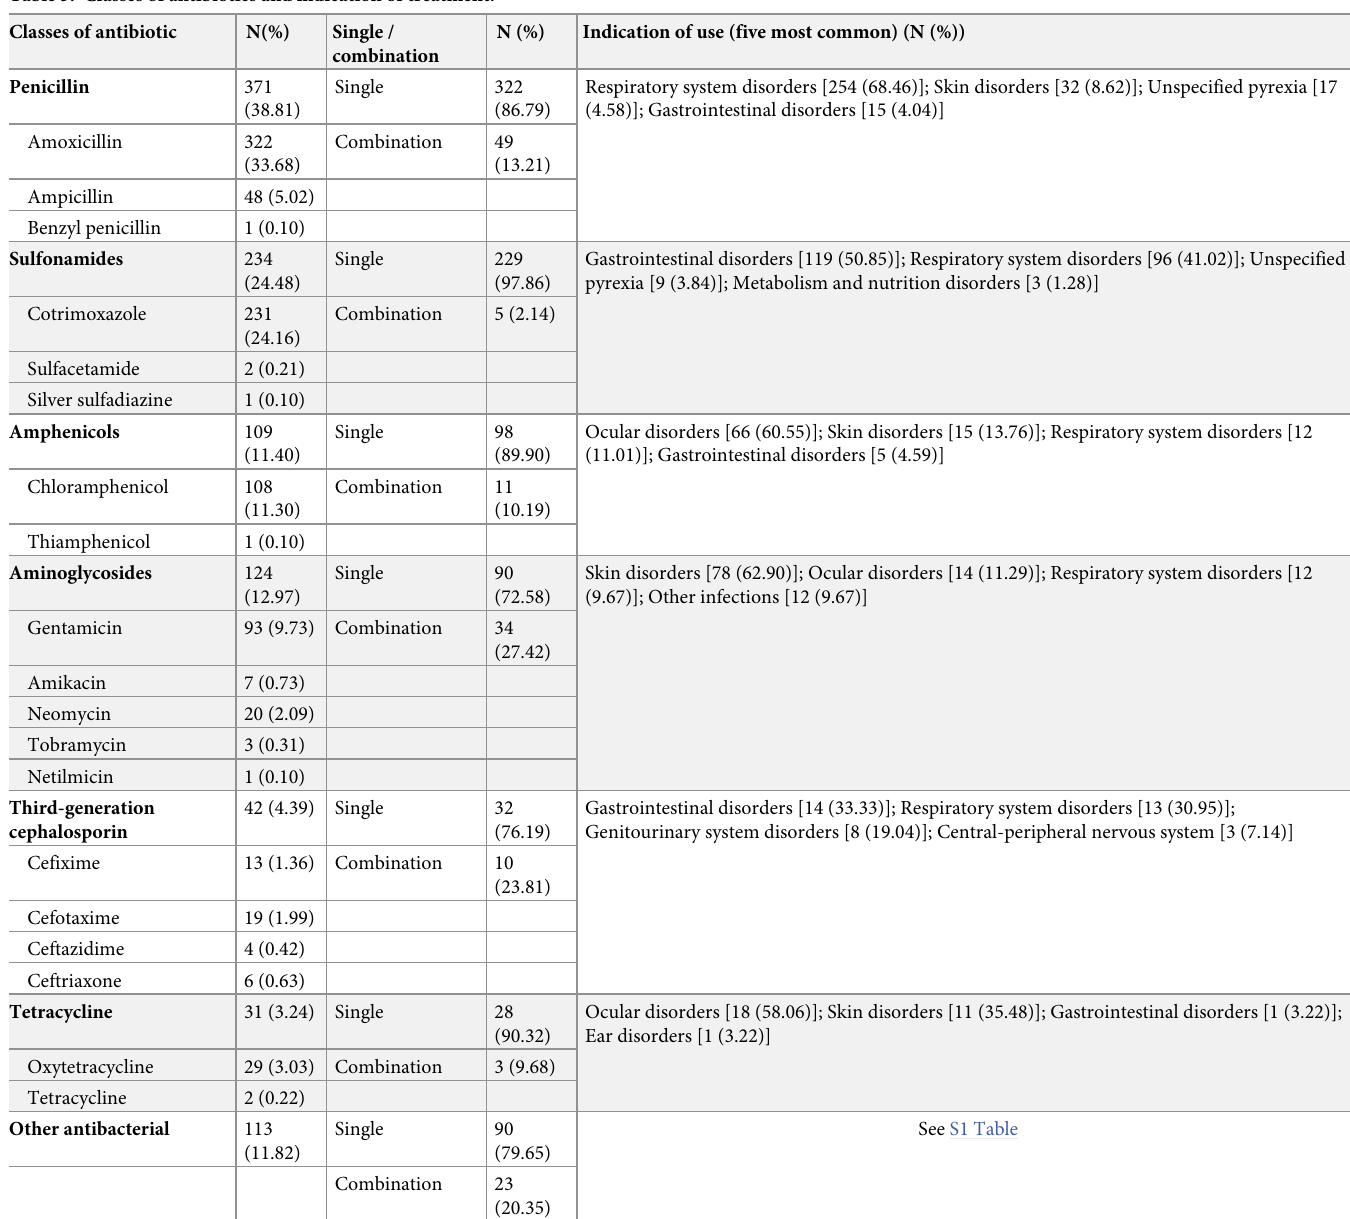
Table 3. Classes of antibiotics and indication of